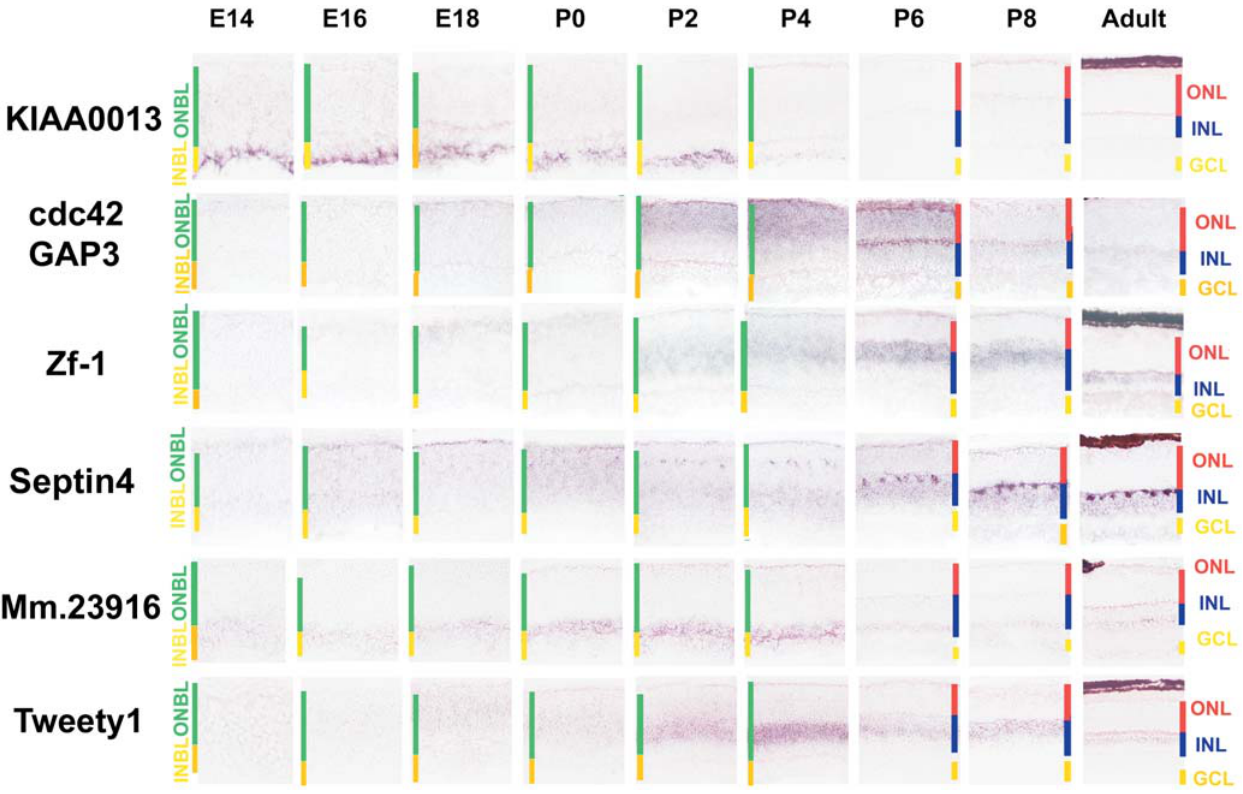
Figure 3. Precursor Patterns for Major Retinal Cell Types Genes that are selectively expressed in immature subtypes of retinal cells. From the top, the differentiating cell types that express the genes in question are ganglion cells (Mm.45753/KIAA0013), rod photoreceptors (Mm.103742/Cdc42GAP), bipolar cells (Mm.29496/Zf-1), horizontal cells (Mm.2214 /septin 4), amacrine cells (Mm.23916), and Mu¨ller glia (Mm.29729/Tweety1). Sections were from central retina. Cellular laminae of both the developing and mature retina are indicated with colored bars. All pictures were taken at 200x. See Table S5 for a full list of probes